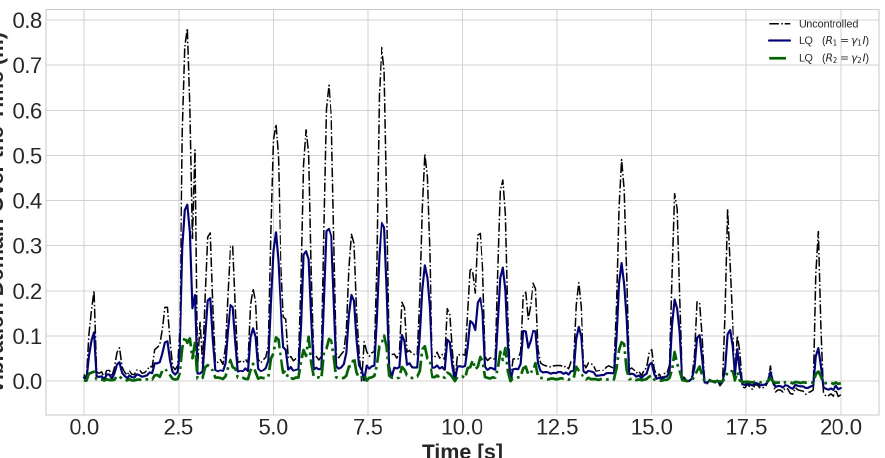
Figure 13. The lateral vibration domain with 2 different Gamma amounts ( γ 1 = 10 − 11 and γ 2 = 10 − 13 ) for the fifteenth sensor under loading number 2 (30-degree attack angle).